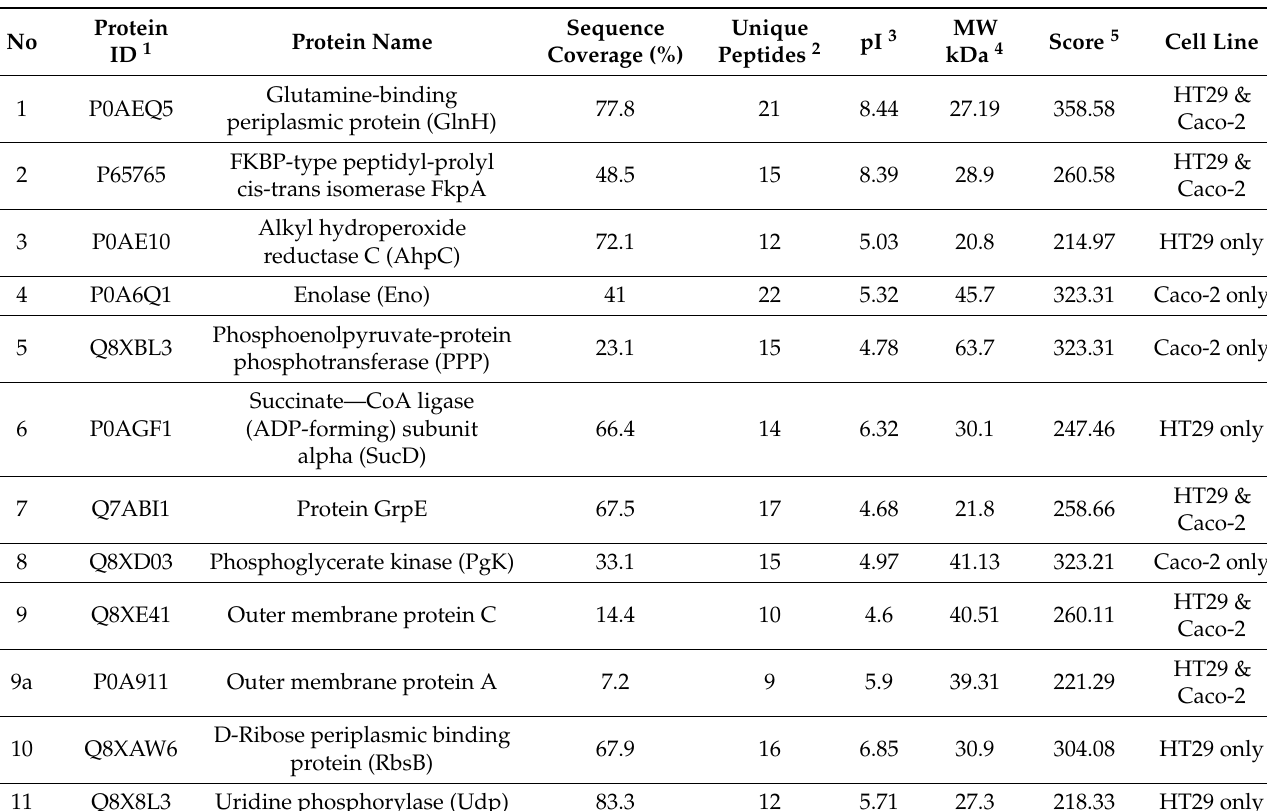
Table 1. Proteins involved in host cell attachment of O157:H7 VTEC prototype strain and the commensal E. coli strain HS to two gastrointestinal cell lines from cell blots probed with HT29 or